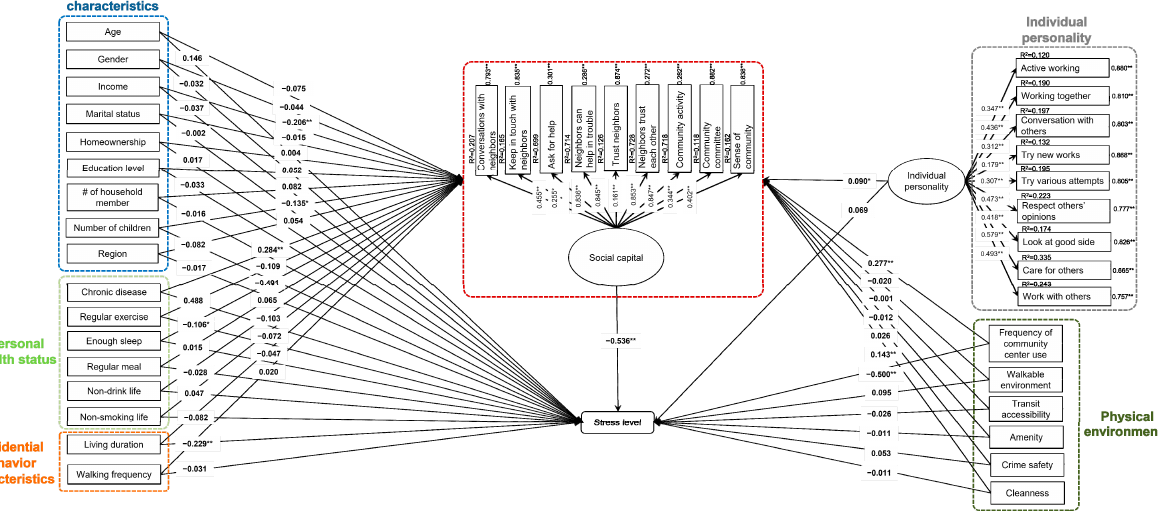
Figure 3. Standardized results of the structural equation model for this study. (**: p < 0.01; * p < 0.05).